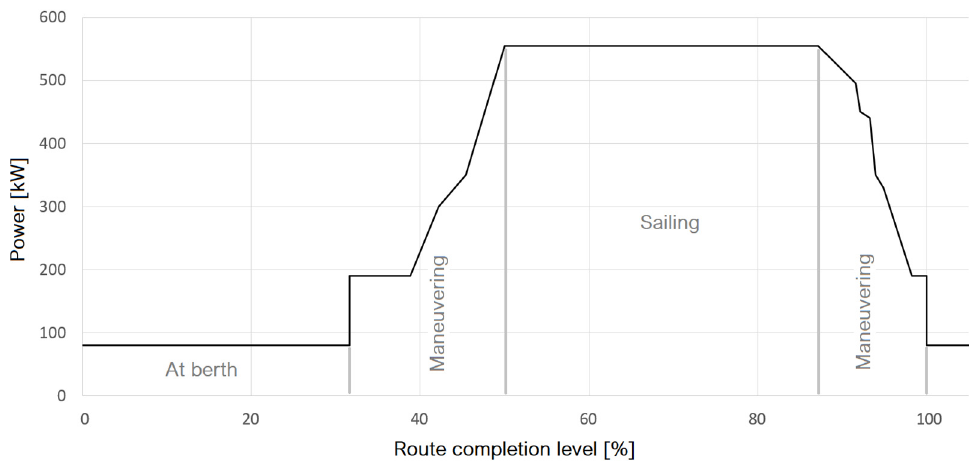
Figure 3. Ship power versus route completion level for the Brestova-Porozina route.